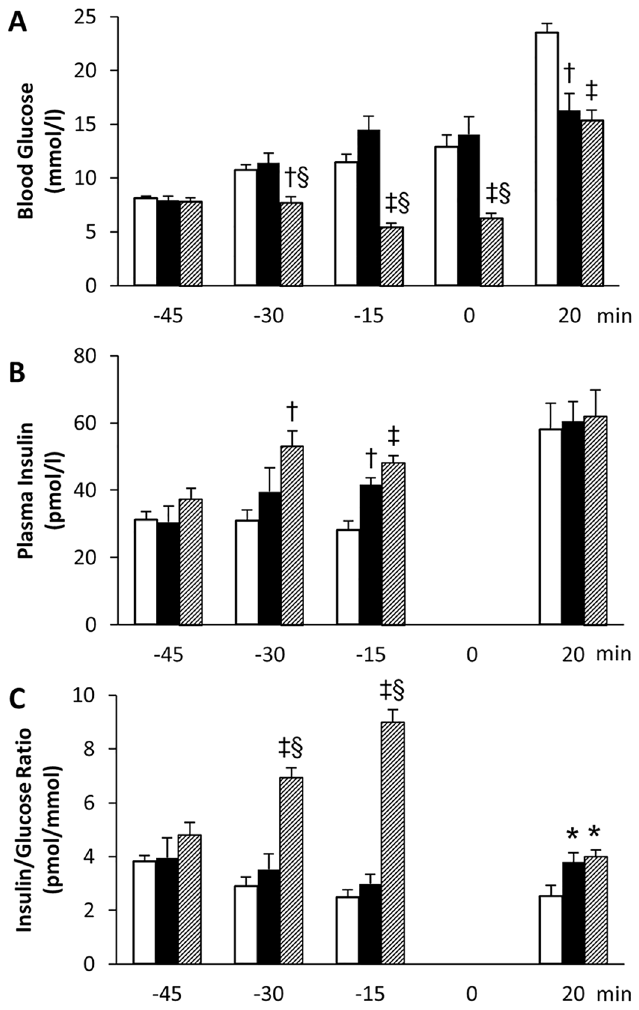
Fig 8. At variance to gliclazide, 55P0110 raises the circulating insulin-per-glucose ratio only under hyperglycaemic conditions. The effects of oral administration at -45 min of vehicle (white bars), 90 mg/kg 55P0110 (black bars), or 16 mg/kg gliclazide (hatched bars) on blood glucose ( A ), plasma insulin ( B ), and the insulin-per-glucose ratio ( C ) in male C57BL/6J mice before and after feeding glucose (3 g/kg at 0 min). Means ± SEM; n = 5 – 6 each; * p < 0.05; † p < 0.01; ‡ p < 0.001 vs. vehicle; § p < 0.05 for gliclazide vs.